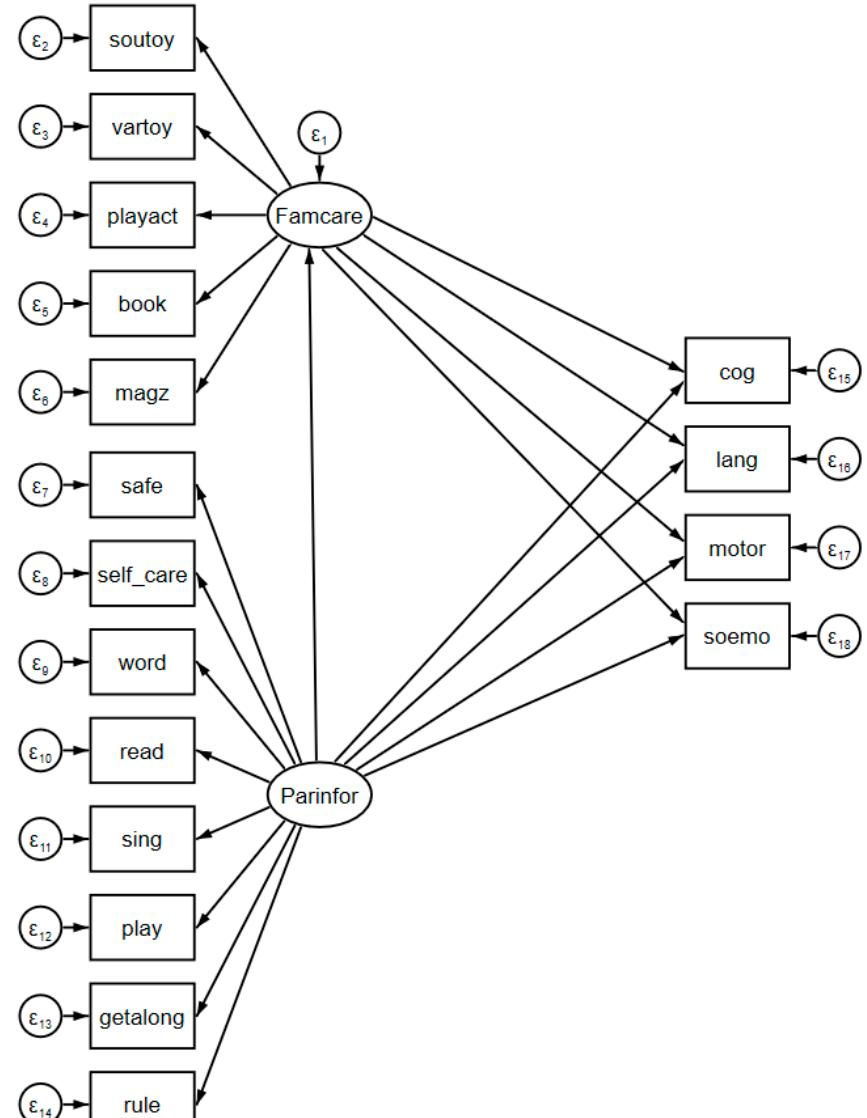
Figure 1. Structural equation modeling (SEM) for the mediation model.